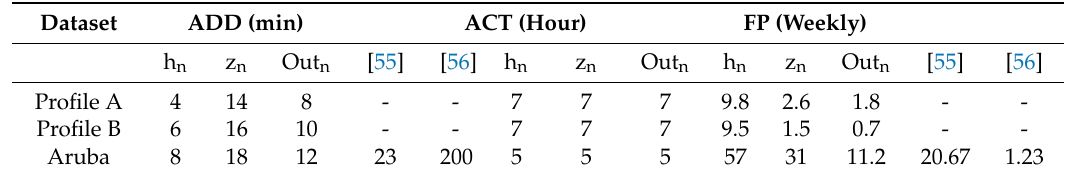
Table 8. Results Summary.